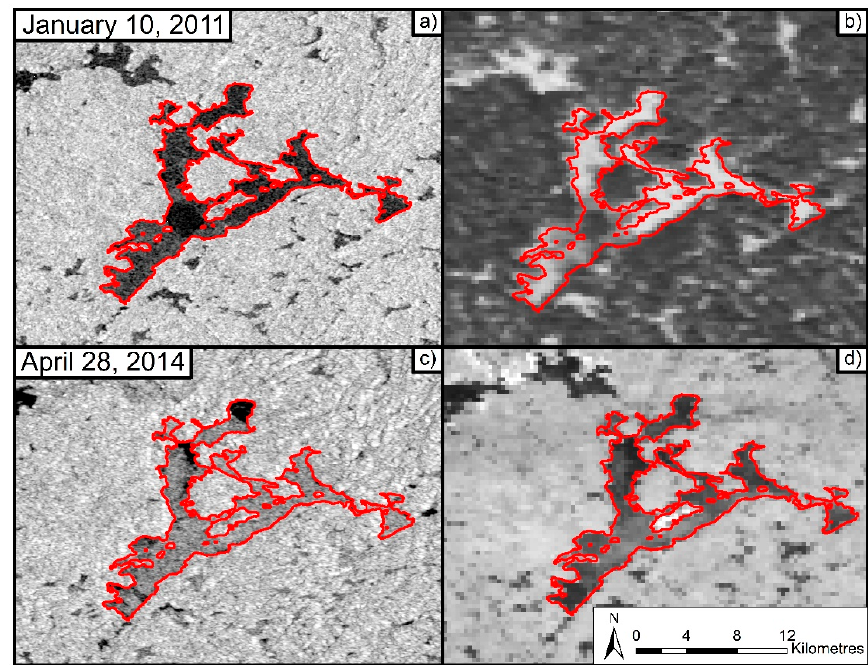
Figure 12. Visual comparison of RADARSAT-2 ( a , c ) to MODIS imagery ( b , d ). The top two panes ( a , b ) show the process of freeze for 10 January 2011 and the bottom two panes ( c , d ) show the process of melt on 28 April 2014. RADARSAT-2 Data and Products © MacDonald, Dettwiler and Associates Ltd. (2011; 2014)—All Rights Reserved. Table 4. Comparison of freeze onset and water clear of ice (WCI) from MODIS visible imagery to RADARSAT-2. Freeze Onset WCI WCI